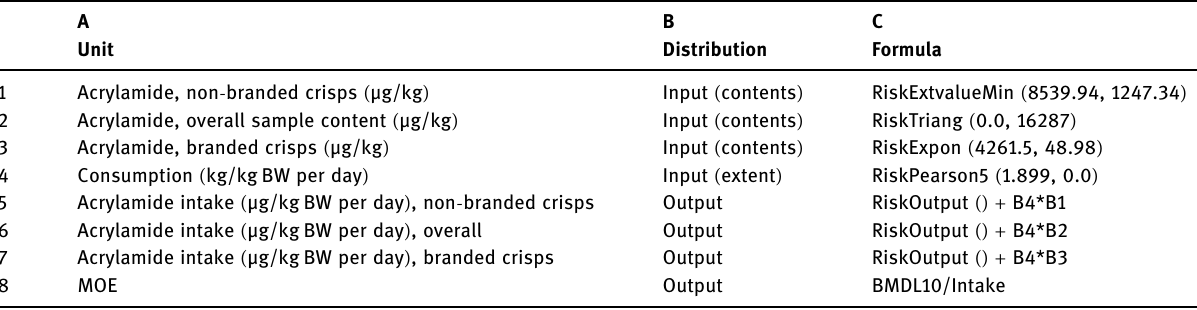
Table 1: Formulae used in quantitative risk assessment model for acrylamide in potato crisps A B Unit Distribution